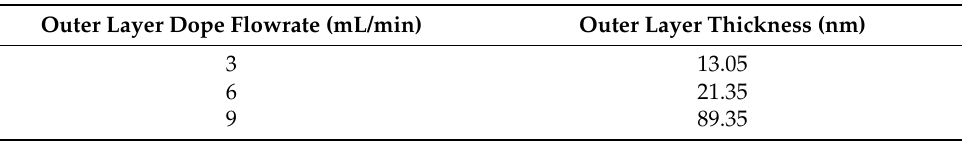
Table 2. Outer layer thickness of 0.25 Cu 2 O/PVDF DLHF membranes for different outer layer dope flowrates: 3 mL/min, 6 mL/min and 9